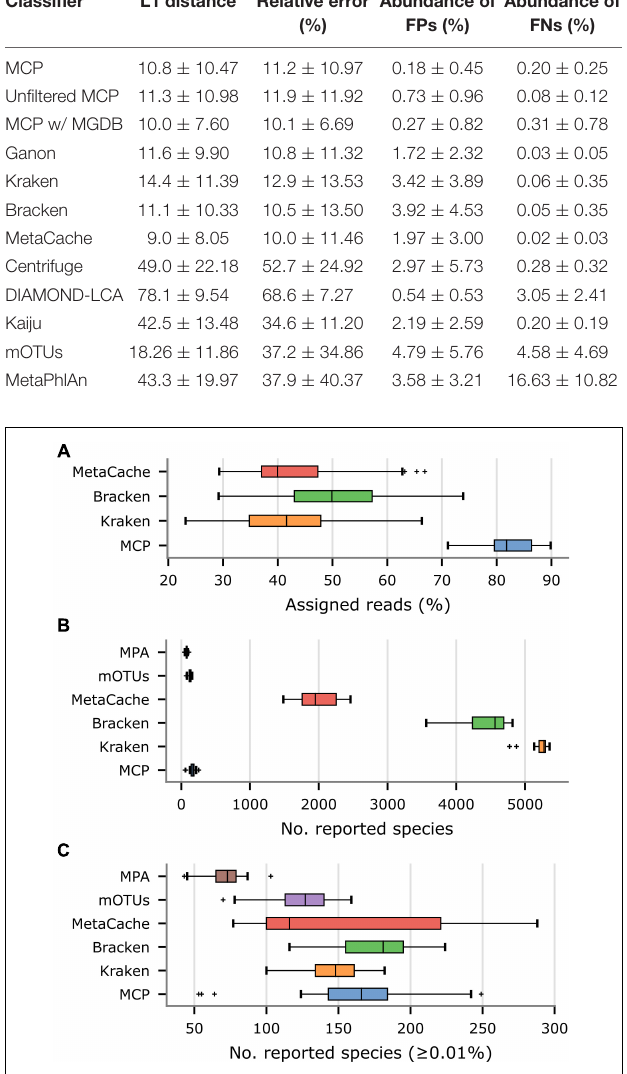
FIGURE 4 | Comparison of metagenomic classifiers on 33 US fecal samples. Community profiles were produced by each classifier using their recommended reference database. (A) Percentage of reads assigned to a species in community profiles. (B) Number of species reported by each classifier. (C) Number of species reported by each classifier with an estimated abundance ≥